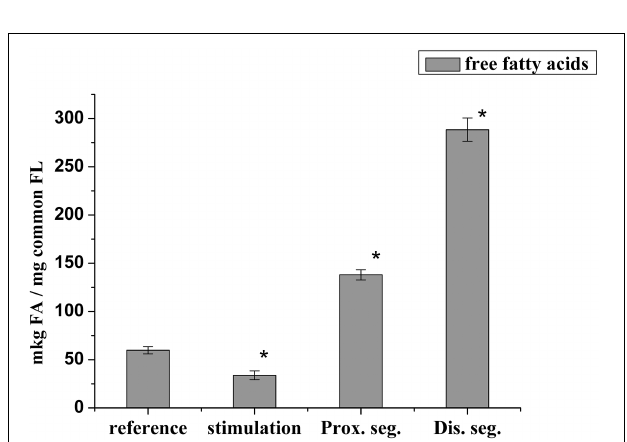
FIGURE 4 | Changes in the content of free fatty acids during the stimulation of the rat myelin nerve and after nerve cutting; ∗ significance of the difference with respect to control, p <